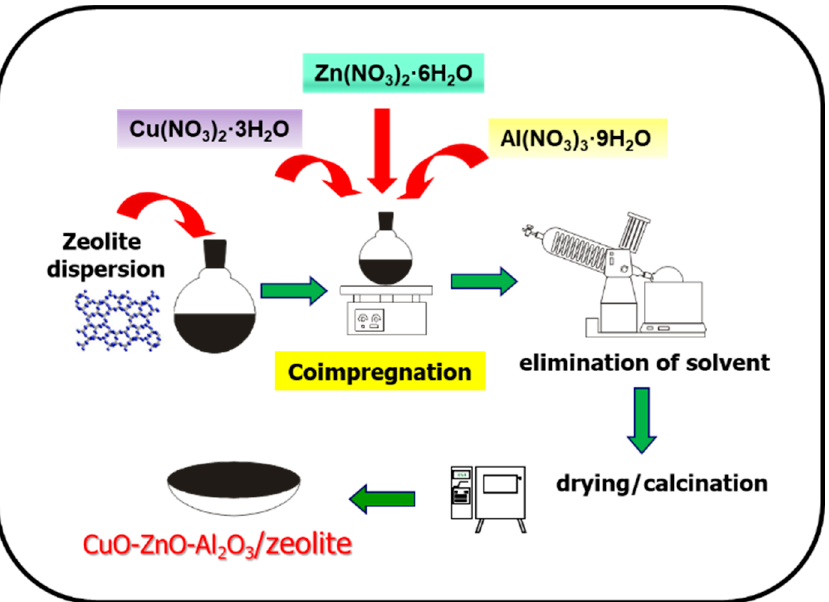
Figure 13. Scheme of the preparation of Cu-ZnO-Al 2 O 3 /zeolite catalysts for direct synthesis of DME using co-precipitation method.